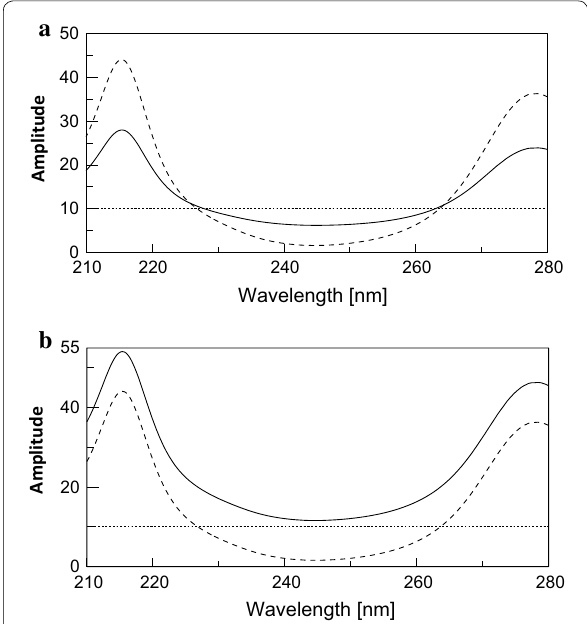
Fig. 6 a Ratio absorption spectra of 10 μg/mL PCT ( dotted line ), 10 μg/mL CAF ( dashed line ) and the binary mixture of CAF and PCT 5 μg/mL of each ( dotted straight line ) obtained after division by the normalized spectra of PCT. b Ratio absorption spectra of 10 μg/mL PCT ( dotted line ), 10 μg/mL CAF ( dashed line ) and the binary mixture of CAF and PCT 10 μg/mL of each ( dotted straight line ) obtained after division by the normalized spectra of